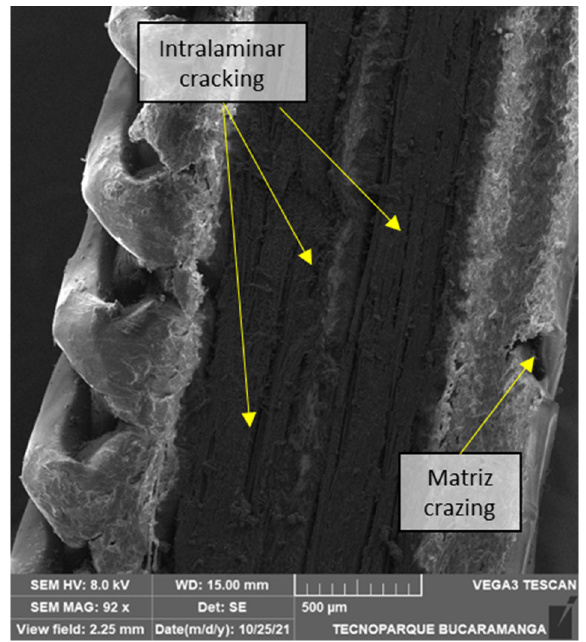
Figure 15. SEM transversal cut of a 4/16 carbon layers 90° flat printed sample.